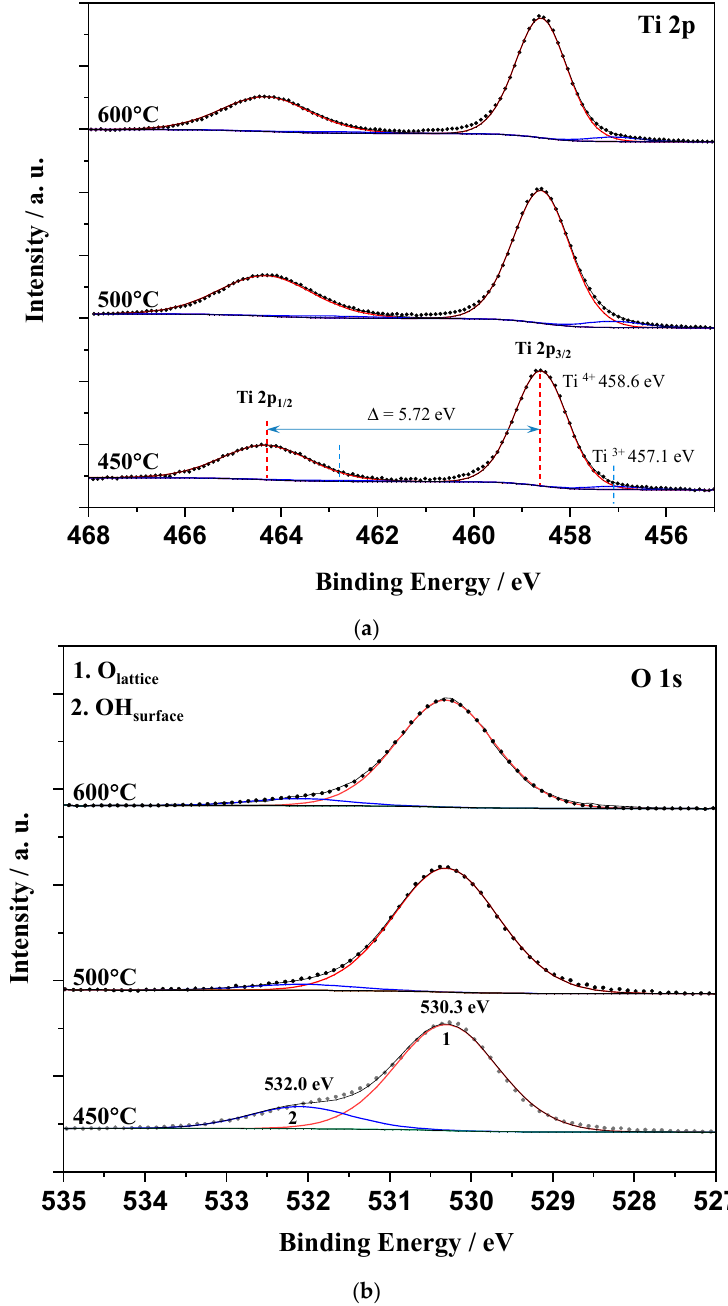
Figure 4. XPS spectra of TiO 2 heat treated at 450–600 °C under hydrogen, ( a ) Ti2p, ( b ) O1s. Ti 2p signal consists of two peaks, Ti2p 1/2 and Ti2p 3/2, with binding energy of 464.4 and 458.6 eV, respectively. The peak at 458.6 eV is slightly asymmetric due to the presence of Ti 3+ species, observed after titania reduction. The calculated quantities of Ti 3+ on the